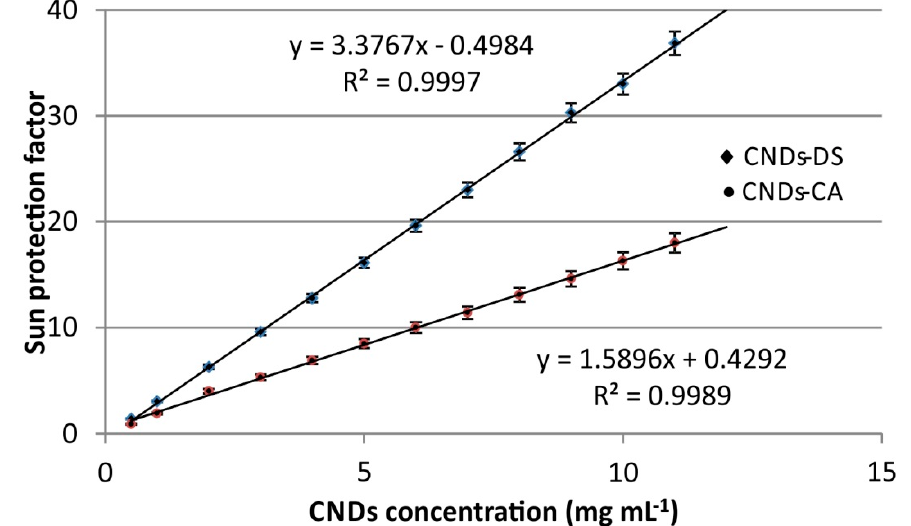
Figure 6. Sun protection factors of CNDs solutions at different concentrations; data are presented as ± standard deviation; n = means ± standard deviation; n = 3. means